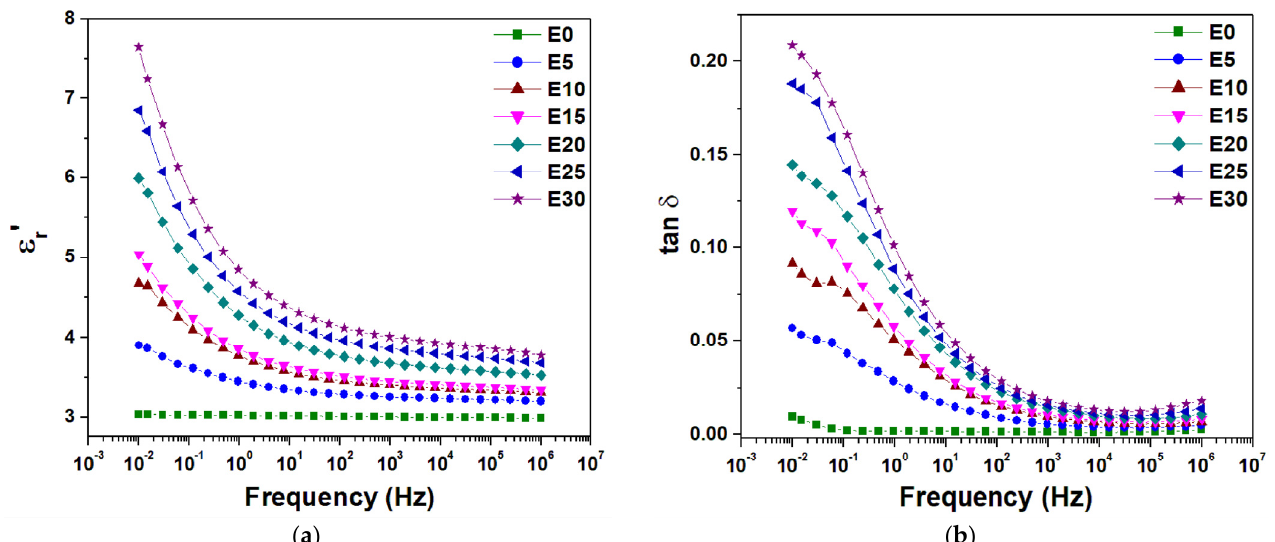
Figure 10. Dependence of ε r ’ ( a ) and tan δ ( b ) versus frequency at 30 °C for nanocomposites with different nanosilica content.